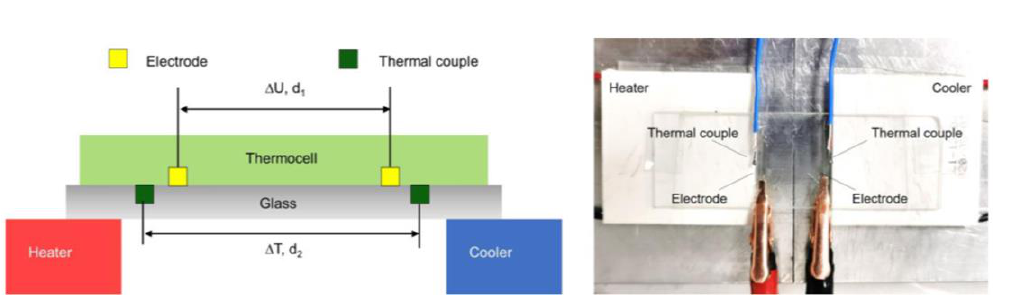
Figure 3. Schematic and digital images of the platform for thermopower measurements. (Repro- duced with permission from [82]. Copyright 2021 Elsevier